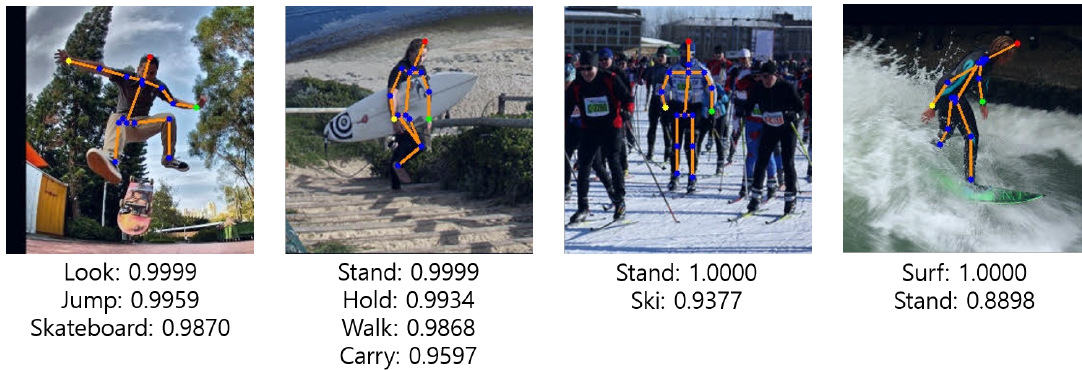
Figure 10. Pose estimation and action recognition results on the V-COCO Dataset [16], which has multi- labels for a person. The ground truth labels and scores for the ground truths are shown below the individual